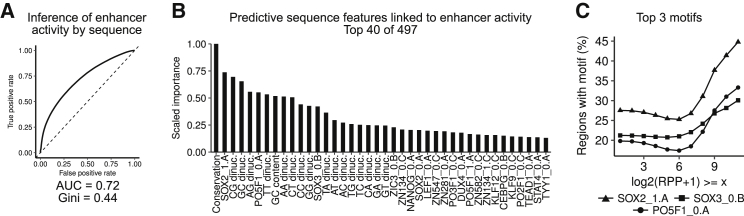
Sequence Determinants of Enhancer Activity(A) Receiver operating characteristic (ROC) curve of the random forest classifier performance. AUC, area under the curve.(B) The top-40 sequence features used to distinguish active and inactive regions ordered by variable importance. HOCOMOCO motif IDs were shortened (Kulakovskiy et al., 2016).(C) Line plots of the percentage of regions containing one of the top-3 motifs from HOCOMOCO as a function of enhancer activity. Each point is the fraction of regions with at least log2(RPP+1) also containing the respective motif.